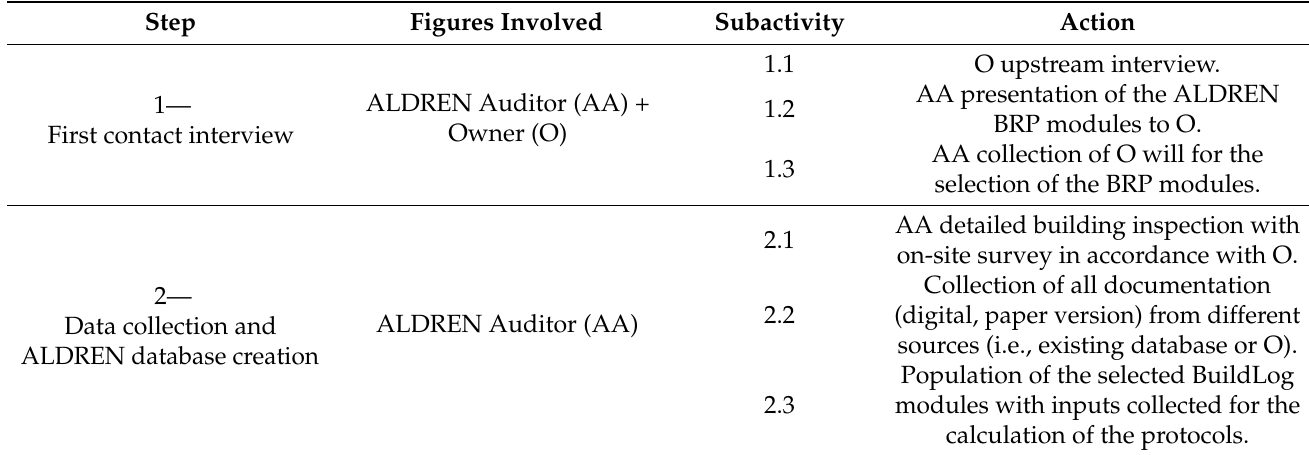
Table 2. Step-by-step procedure for the ALDREN Building Renovation Passport